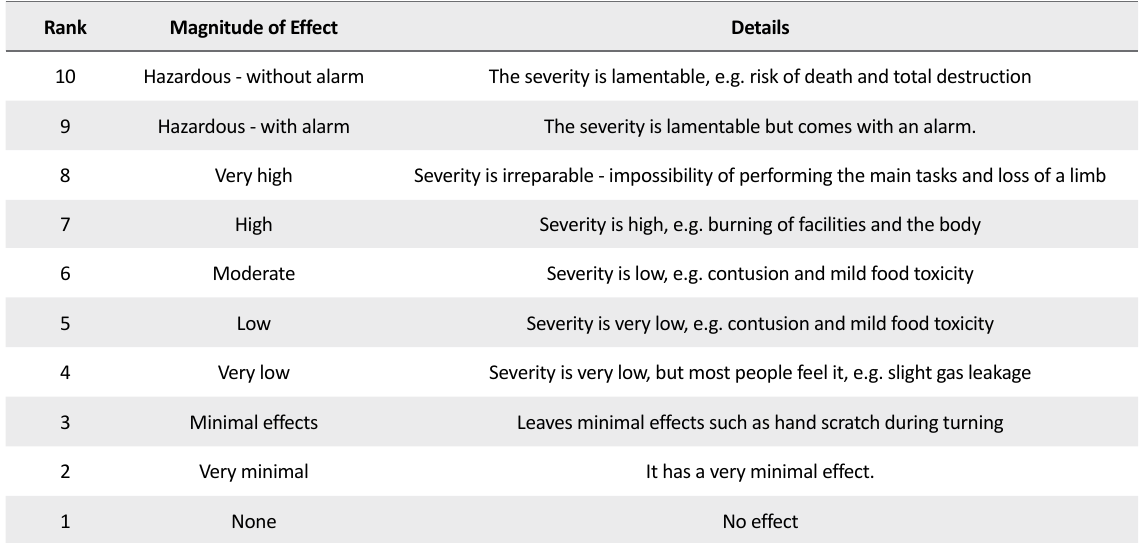
Table 1. Hazard severity Rank Magnitude of Effect